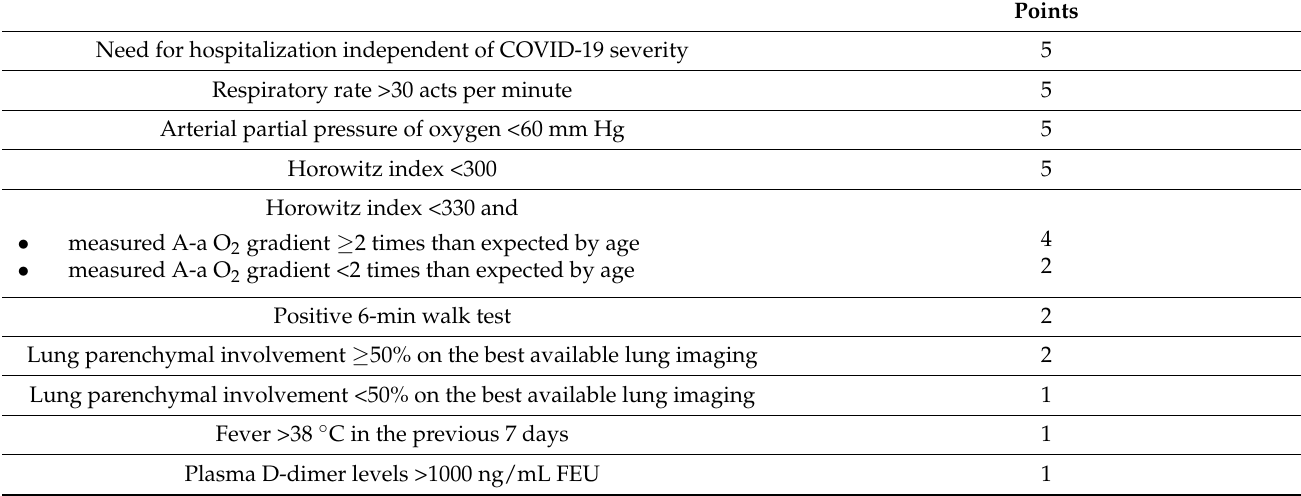
Table 1. Acute PNeumonia early assessment (aPNea) score